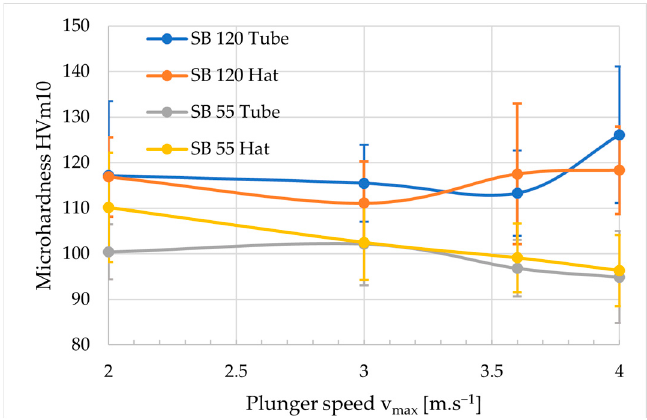
Figure 16. Microhardness dependence on plunger speed v max .